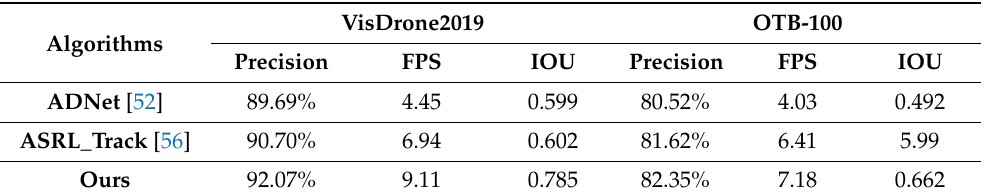
Figure 9. In this plot, comparison results of three different types of RL-based recent works are shown. The red (ADNet [52]), green (ASRL_Track [56]), and blue (ours) colors show the result of comparison in testing the ( a ) VisDrone2019 and ( b ) OTB-100 datasets respectively. Table 3. Comparison results of recent tracking algorithms with proposed method on VisDrone2019 and OTB-100 datasets.